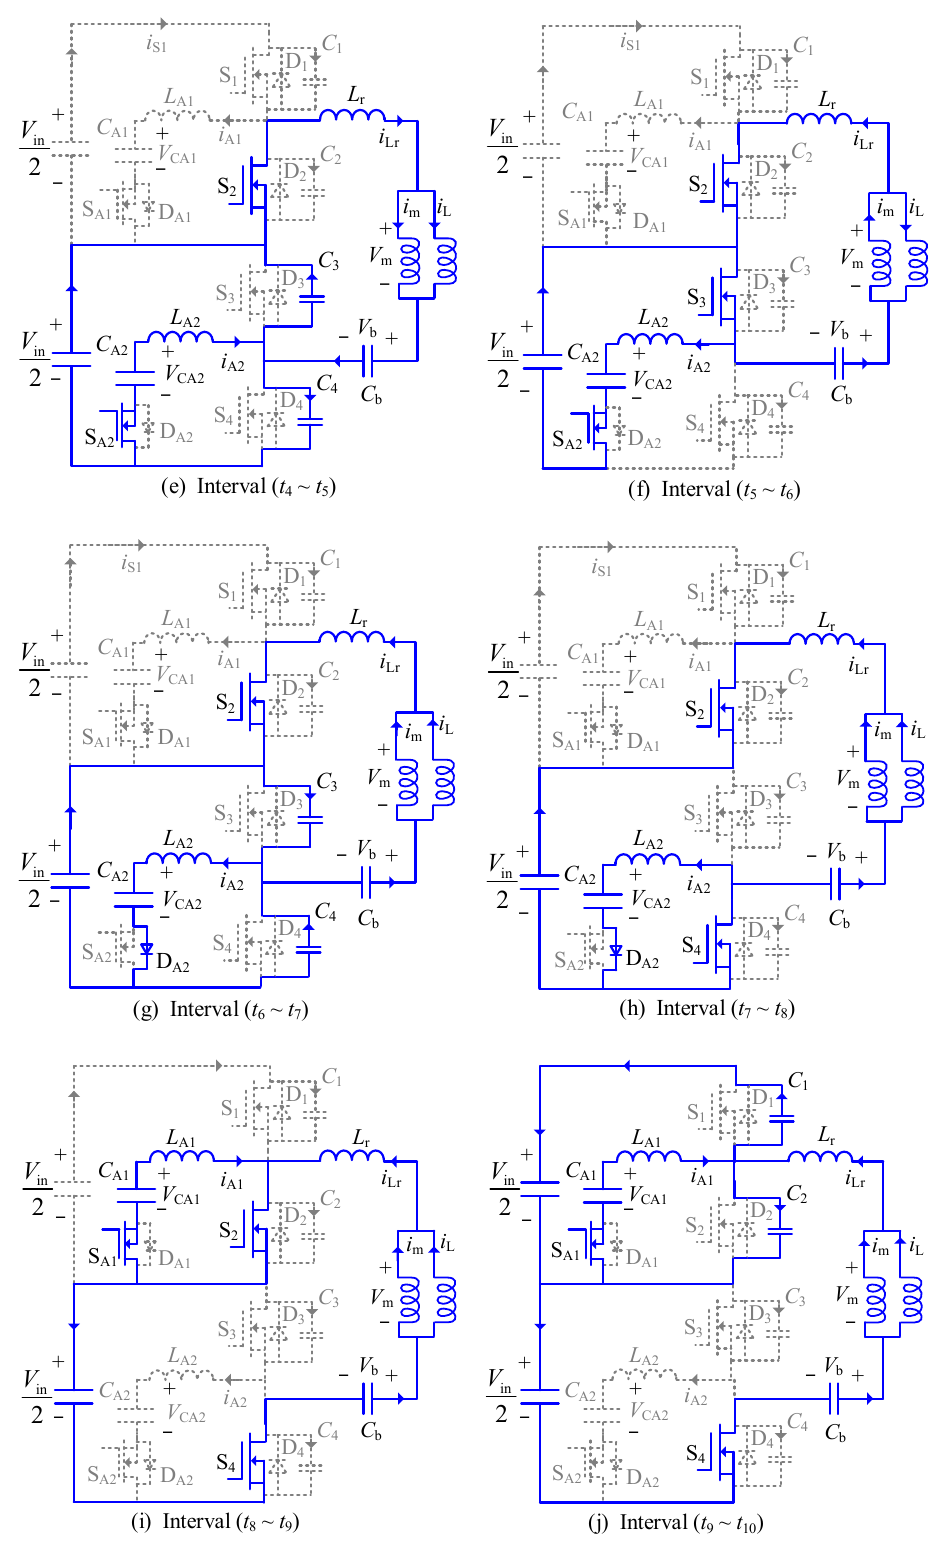
Figure 5. Equivalent circuits for each time interval. ( a – j ) are the equivalent circuits of interval 1– interval 10 respectively.